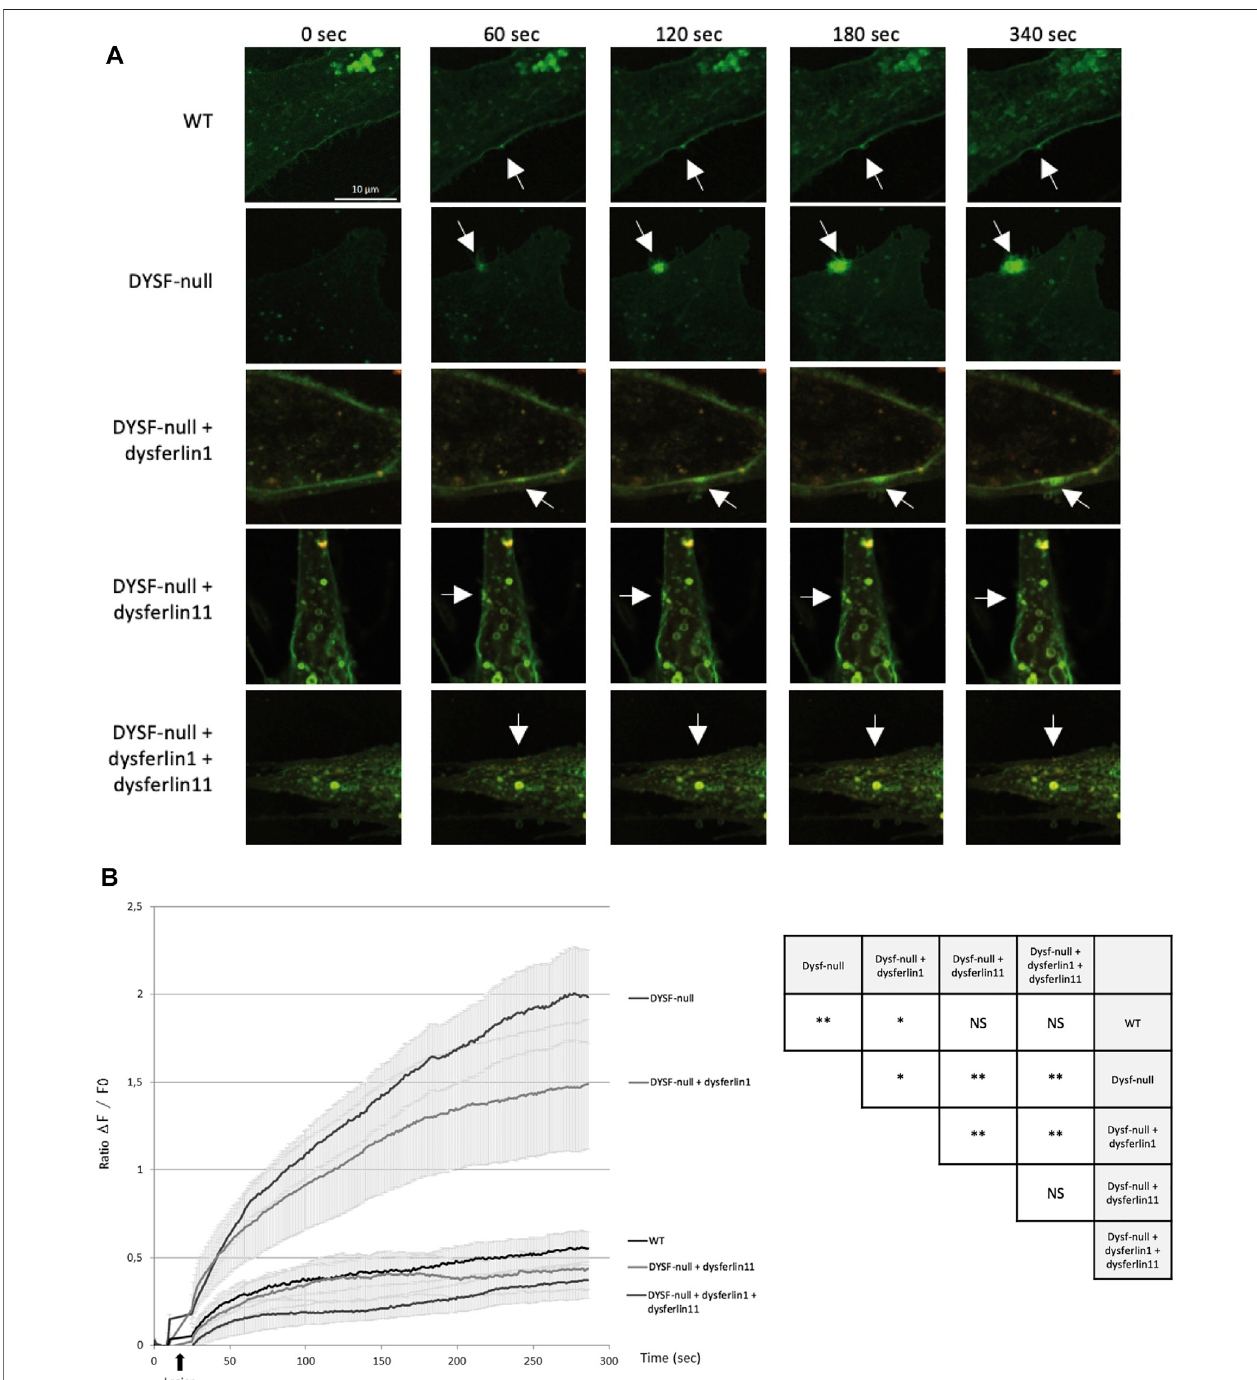
FIGURE3| Dysferlin11transcriptisessentialforcellmembranerepair. (A) Membranerepairassayperformedonhumancontrolmyoblasts(WT,C25),dysferlin-null human myoblasts (DYSF-null, AB320) and transfected dysferlin-null myoblasts (DYSF-null + mCherry-dysferlin1, DYSF-null + mCherry-dysferlin11, DYSF-null + mCherry-dysferlin1 + mCherry-dysferlin11) in the presence of Ca2+ and membrane-impermeable dye FM 1-43. Fluorescence images were taken every second for 5 min. The damage was induced at t (cid:2) 10 s. Scale bar, 10 µM. White arrows indicate the injury site. (B) Summary data for membrane repair assay. Black arrows indicate injury-time point. Data are mean ± SEM (Standard error of the mean) for n (cid:2) 20 cells. Statistical analysis was performed using Mann-Whitney test. In order to facilitate the interpretation of the different comparisons between the conditions, the table on the right-hand side of the fi gure summarizes the statistical results obtained. (NS: non-signi fi cant, *: p -value < 0.05, **: p -value < 0.01).